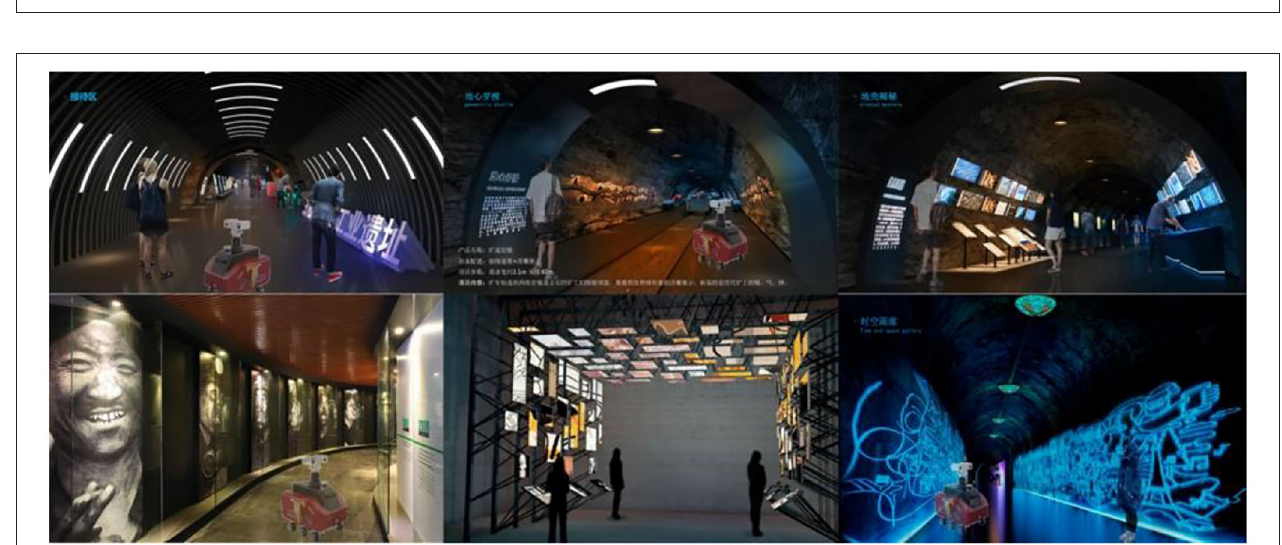
FIGURE 5 | Underground landscape regeneration design of coal mine.